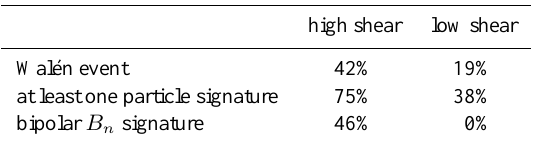
Table 1. Occurrence rate of reconnection signatures for high and low magnetic shear